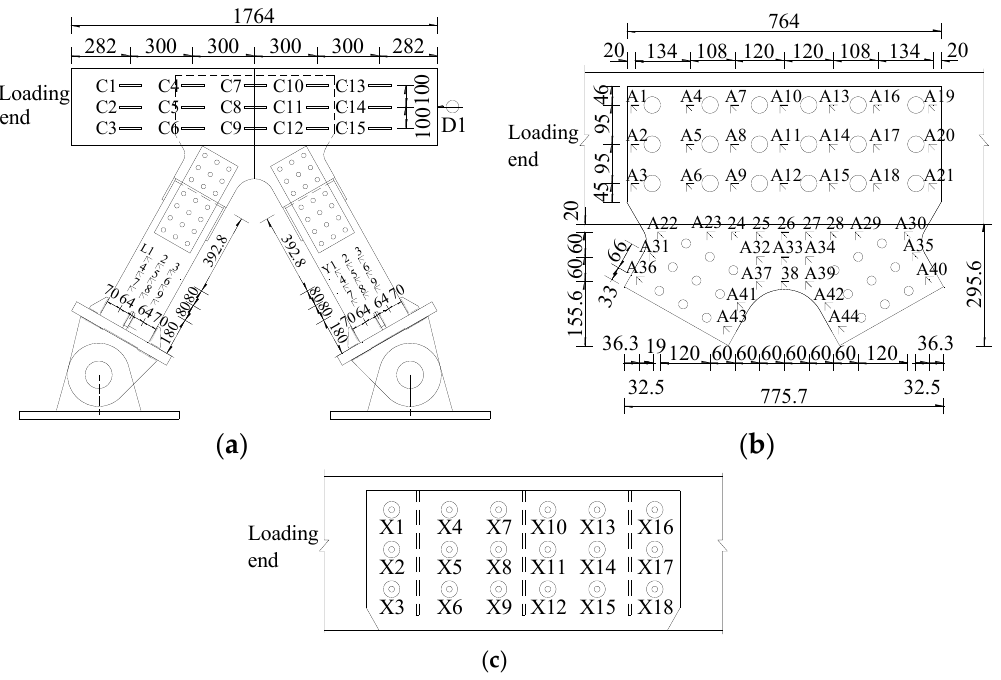
Figure 4. Arrangement of the displacement meters and strain gauges (unit: mm). ( a ) The concrete chord and steel truss-web members; ( b ) the gusset plates; and ( c ) the PBL shear connectors. C1: No. 1 strain gauge of concrete chord; A1: No. 1 strain gauge of gusset plates; X1: No. 1 strain gauge of PBL shear connectors.